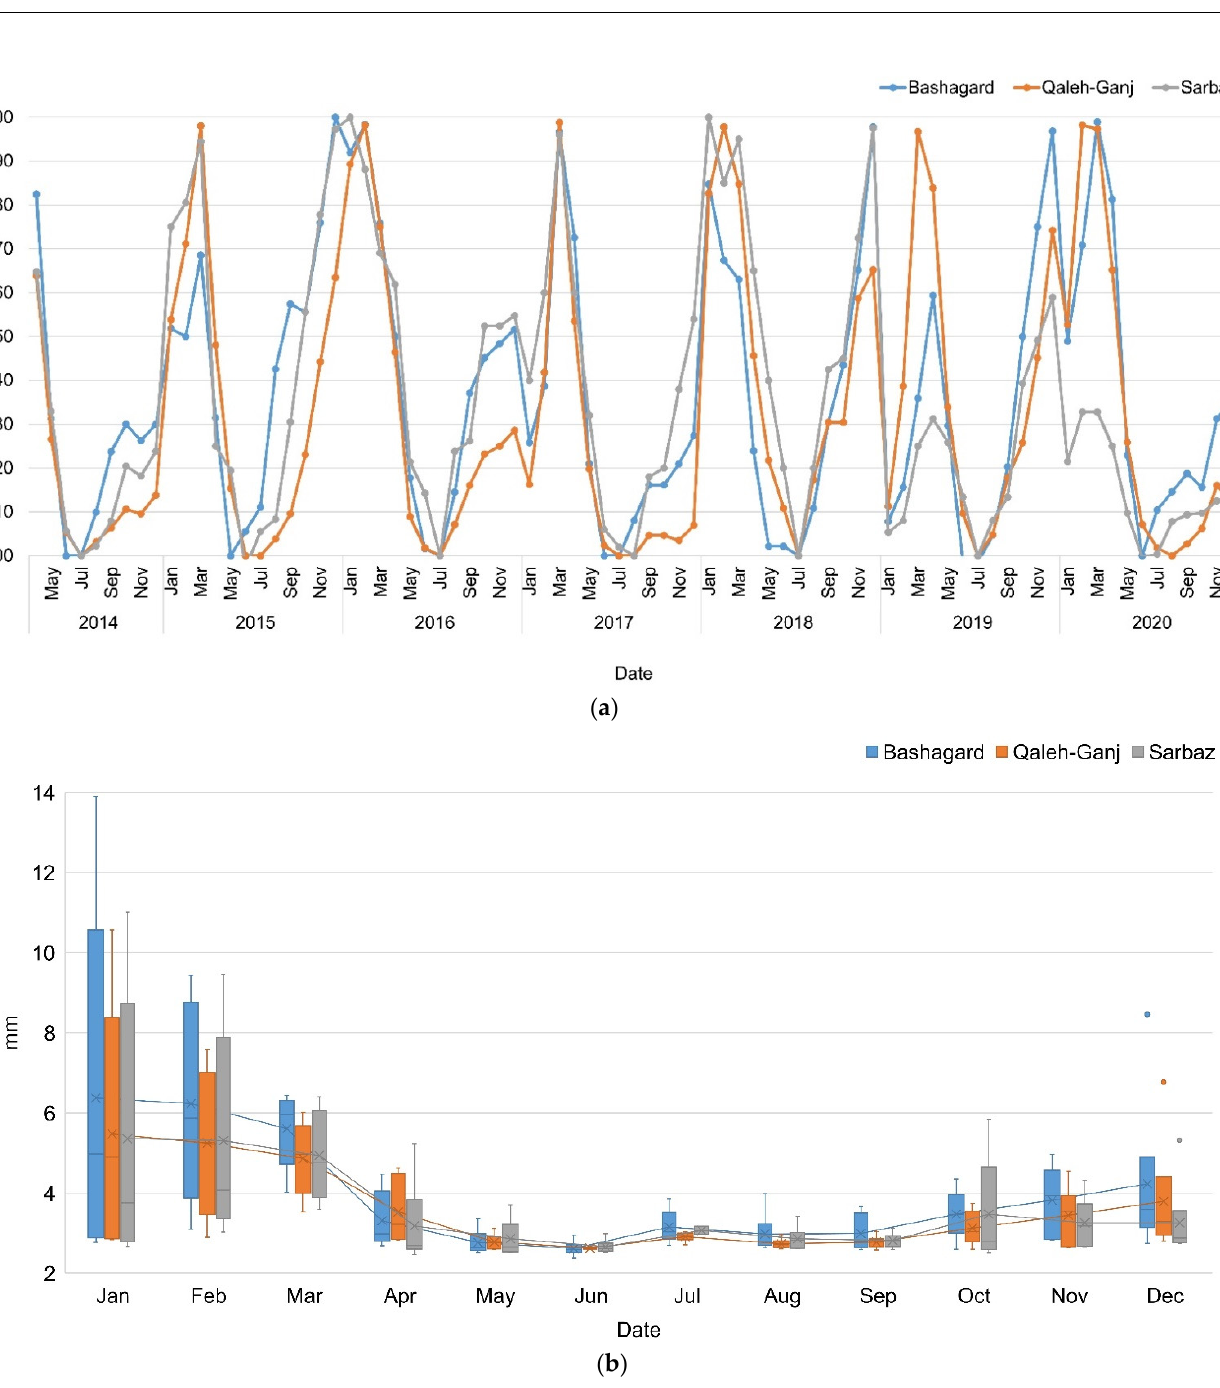
Table 5. Correlation between TCI and LST.